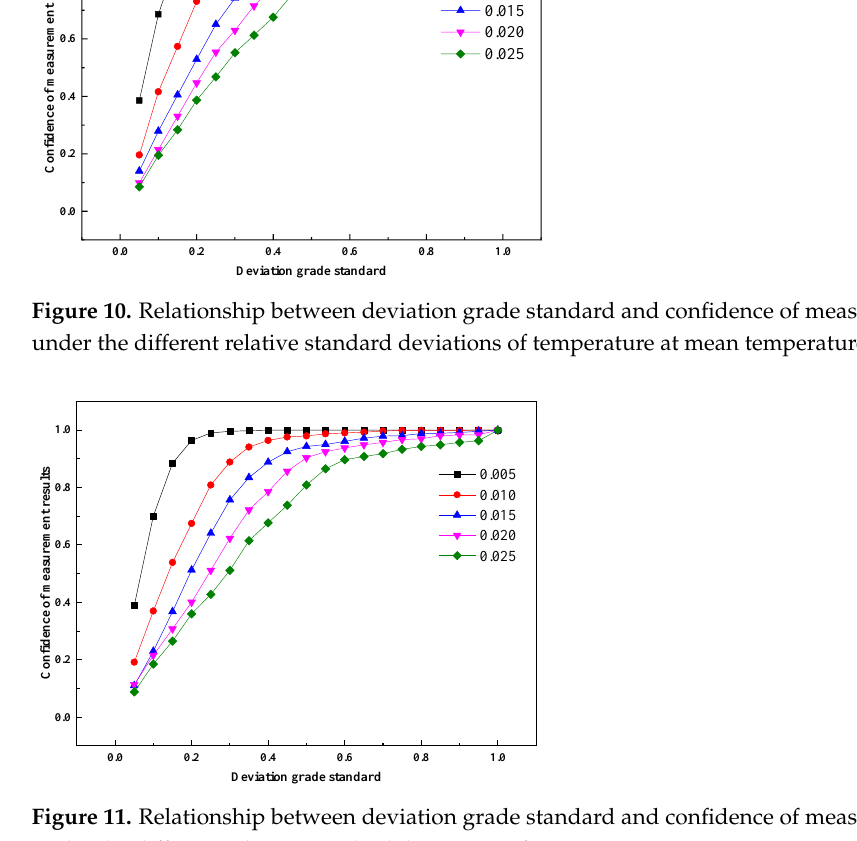
Figure 12. Relationship between relative standard deviation of temperature and confidence of measurement results at deviation grade standard of 0.25. It can be seen from Figures 9 – 11 that the relative standard deviation of temperature has a great impact on the confidence of measurement results under different deviation grade standards. Under the same deviation grade standard, the confidence of the meas- urement results gradually decreases as the relative standard deviation of temperature increases, and the corresponding probability of erroneous measurement of outlet NO concentration is higher, which also conforms to the law that the worse temperature uni- formity, the stronger the difference in chemical reaction, the more nonuniform the dis- tribution of outlet NO concentration, and the easier it is to measure inaccuracy. The larger the deviation grade standard, the higher the confidence of the measurement re- sults. When the deviation grade standard increases to a certain value, the confidence of the measurement results under the relative standard deviation of five temperatures can reach more than 0.9. The National Environmental Protection Standard of the People ’ s Republic of China “ Technical Specifications for Continuous Monitoring of Flue Gas (SO 2 , NO x , Particulate Matter) Emissions from Stationary Pollution Sources HJ 75-2017 ” [27] states that the de- tection accuracy of NO x is as follows: 20 μmol/mol (41 mg/m 3 ) ≤ emission concentration < 50 μmol/mol (10 3 mg/m 3 ), the relative error shall not exceed ±30%; emission concentra- tion < 20 μmol/mol (4 1 mg/m 3 ), the absolute error shall not exceed ±6 μmol/mol (12 mg/m 3 ). Therefore, the deviation grade standard is set as 0.25 in this paper. We specify that the confidence of measurement results is greater than or equal to 0.90 as high relia- bility, that is, when the deviation of the center concentration is less than or equal to 0.25, the NO concentration measured at the center measurement point can represent the av-